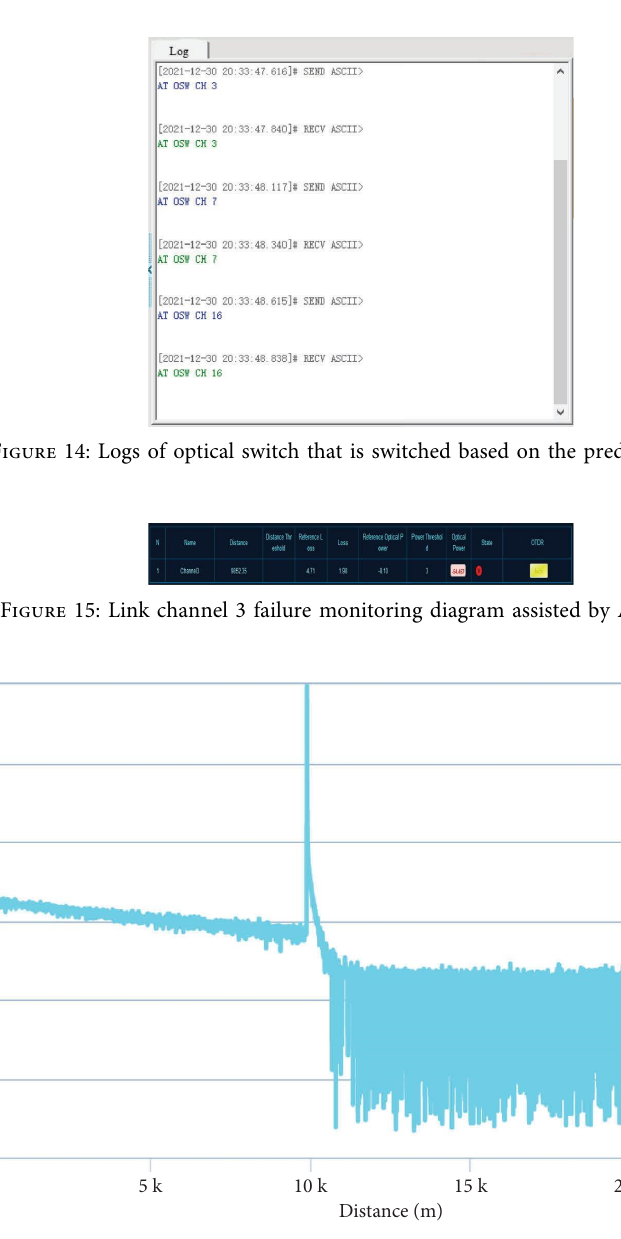
Figure 16: Diagram of OTDR detection